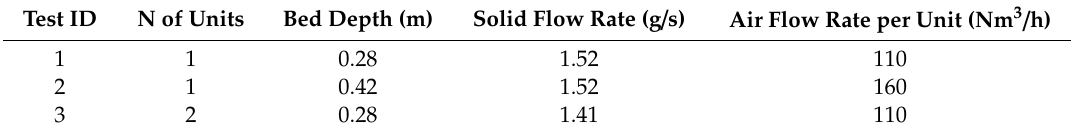
Table 3. Conditions of the experimental